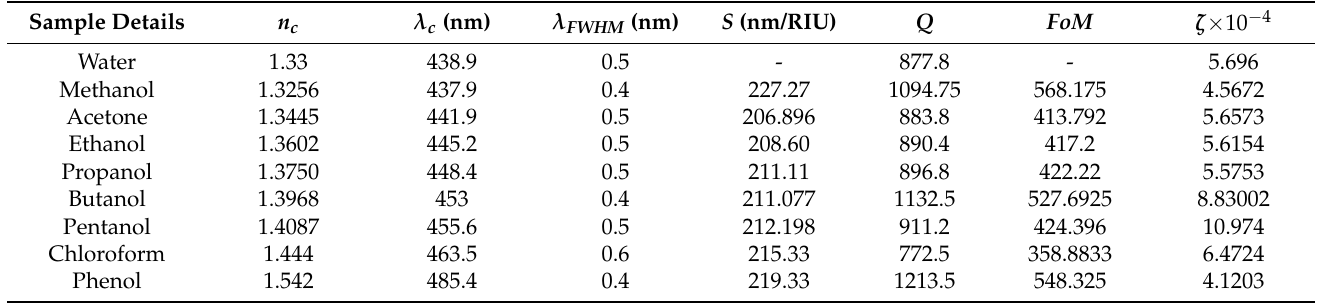
Table 3. Bio-alcohol sensor performance with d c = 125 nm corresponding to θ = 70 ◦ .